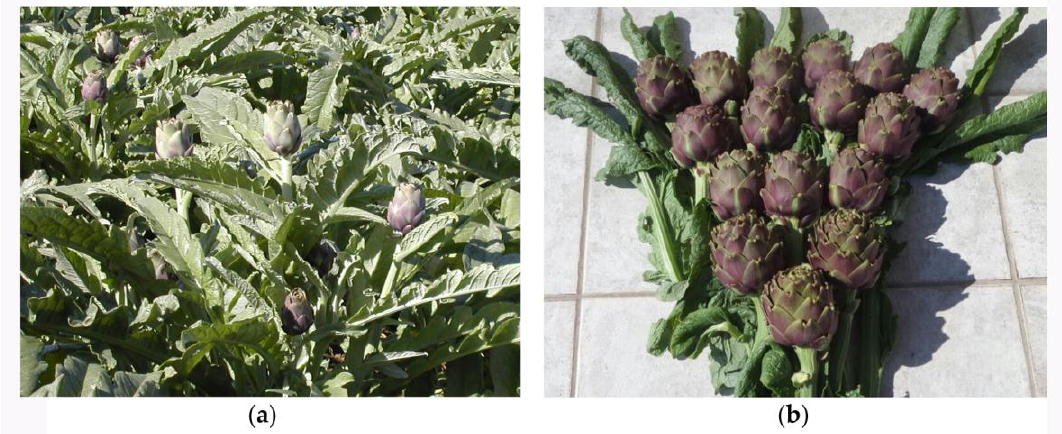
Figure 5. Production of sanitized clones of ecotypes “Locale di Mola” ( a ) and “Violetto di Putignano” ( b ) in a small-scale experimental field for a preliminary evaluation of agronomic traits after sanitation.